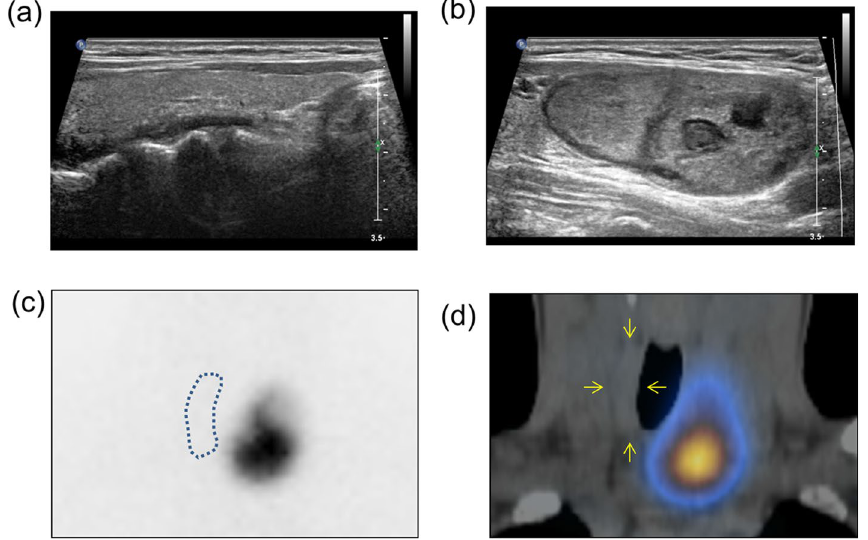
Fig. 1 An autonomously functioning thyroid nodule. The neck ultrasound does not show abnormal findings in the right lobe ( a ), while a large thyroid nodule (3.44 ( b ). Tc-99m pertechnetate scan reveals a hot nodule in the left lobe, while the right lobe is suppressed, as demonstrated on the planar scan (dotted line) ( c ) and SPECT/CT (small arrows) ( d ). SPECT